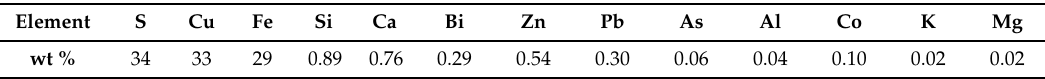
Table 1. Elemental composition of chalcopyrite sample measured by ICP-AES (total error for each element: